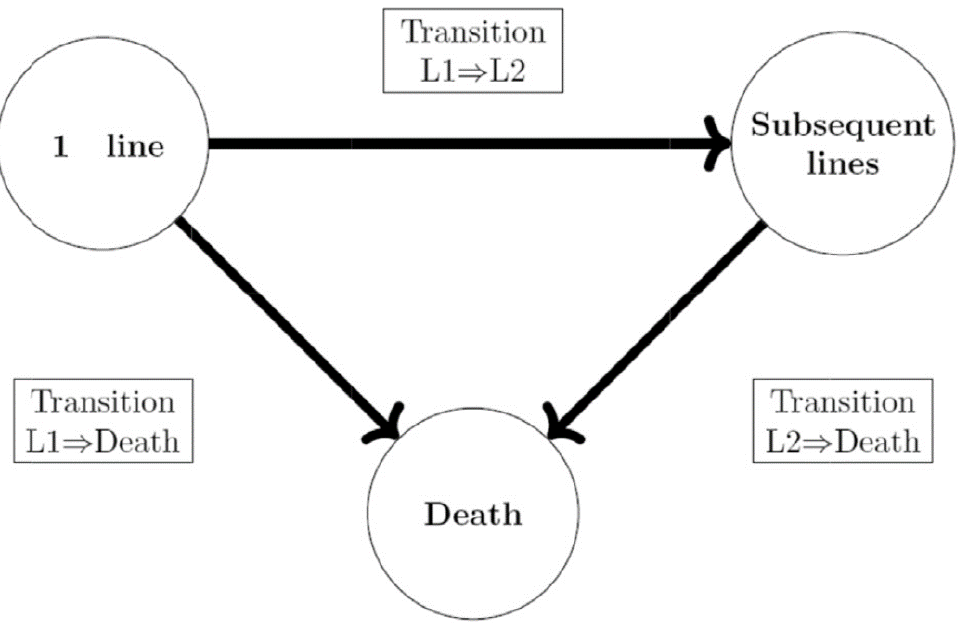
Figure 1. Multistate model. Legend: in such a model, the course of the disease is described using exclusive and exhaustive health states. The state occurrence and occupancy time depend on pa- tients’ characteristics and time already spent in the present and previous states, meaning that the probability of moving to other states is influenced by the patient’s history and characteristics. In our case, the MSM described the individual patient’s treatment course ( i.e., sequence) after their diag- nosis of AM, with three states: “first line of treatment”, “subsequent lines of treatment” , and